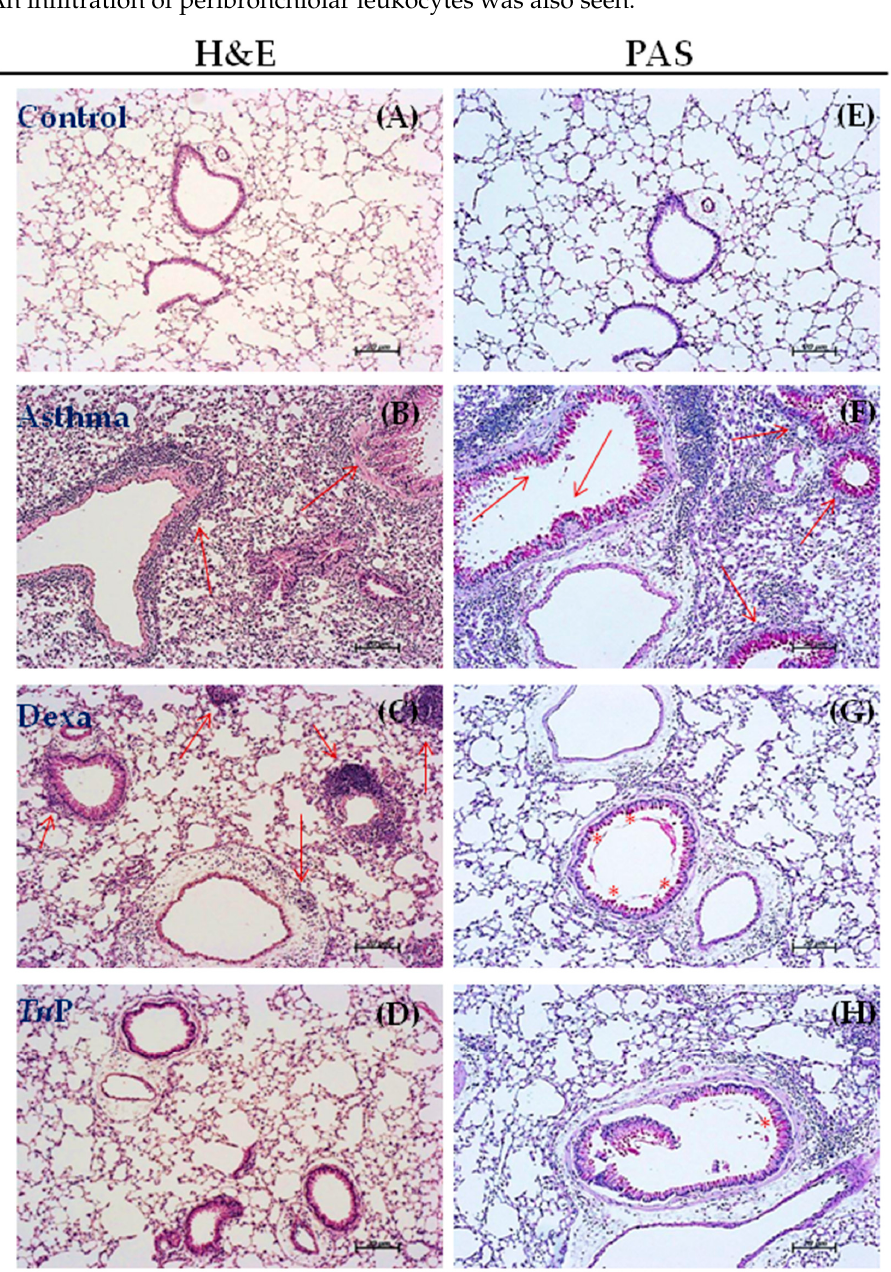
Figure 2. Tn P reduces lung cell infiltration and hyperplasia of mucus-producing cells. Lung sections stained with H&E ( A – D ) and PAS ( E – H ) show normal cellularity or morphology in control mice ( A or E ), and perivascular, peribronchiolar and interstitial eosinophils in the asthma group, ( B ) with intense hyperplasic goblet cells ( F ). Tn P-group mice show no eosinophil infiltration ( D ) or hyperplasic goblet cells ( H ). Dexa decreased the recruitment of leukocytes in relation to the asthma group, but maintained infiltration of peribronchiolar leukocytes ( C ) and hyperplasic goblet cells ( G ). The red arrows indicate the intense perivascular, peribronchiolar and pulmonary interstitial leukocyte infiltration, and red asterisks are indicative of hyperplasic goblet cells.